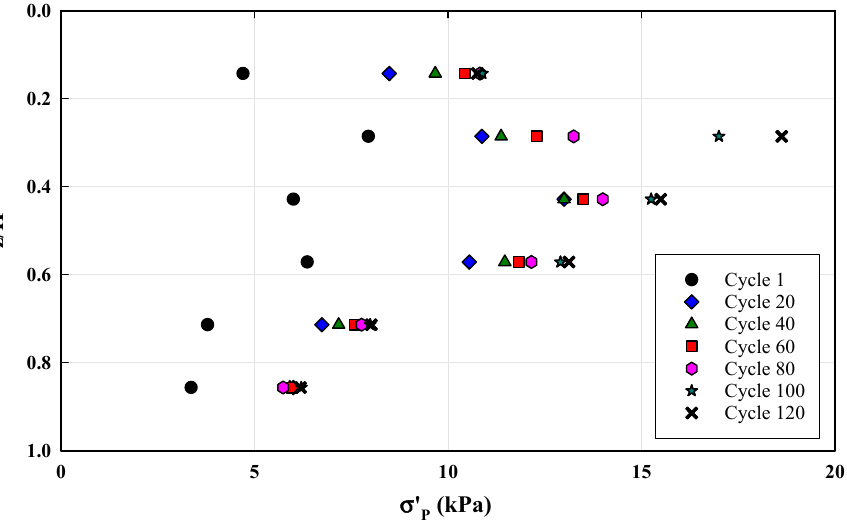
Figure 13. Variation of lateral pressure during loading cycles for geogrid-reinforced backfill.